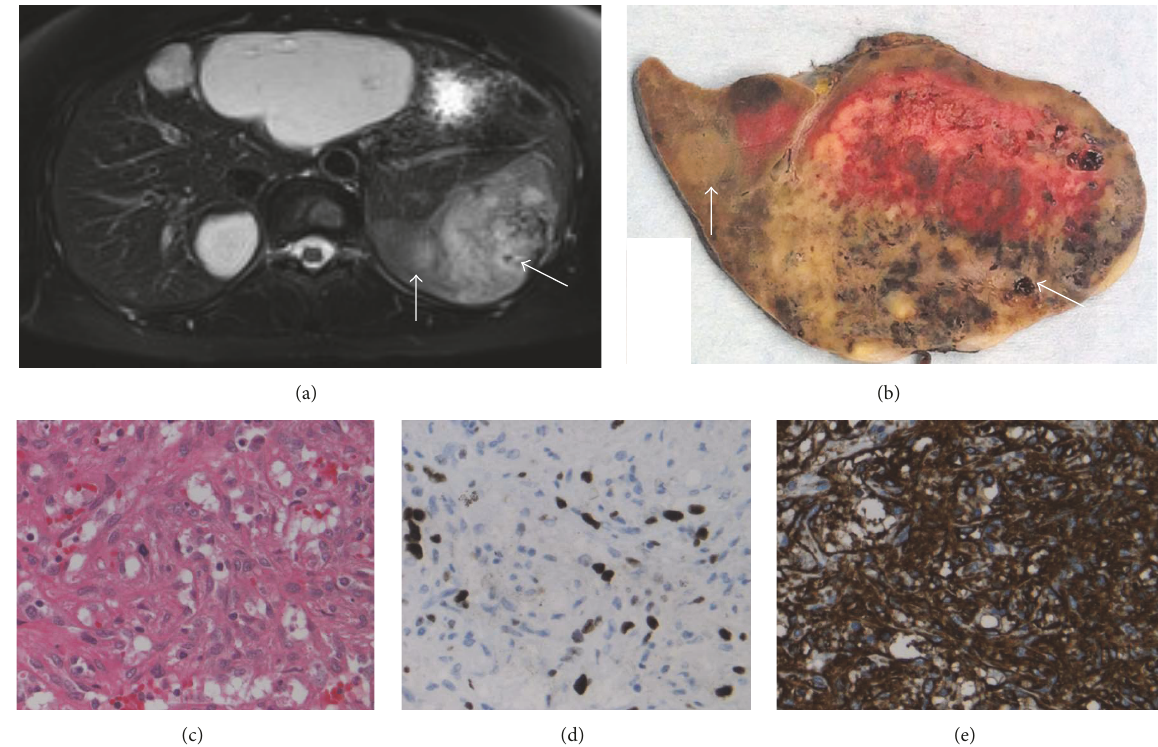
Figure 1: Epithelioid hemangioendothelioma arising within the spleen. (a) Axial MRI scan showing liver hemangiomata (white masses) and vascular splenic lesions. (b) Gross specimen following splenectomy. White arrows correspond to imaging findings in (a). (c) H&E staining demonstrated a highly cellular, atypical complex vascular lesion with rare mitotic figures. (d) MIB-1 staining illustrates a proliferation index of approximately 10%. (e) Immunophenotyping with